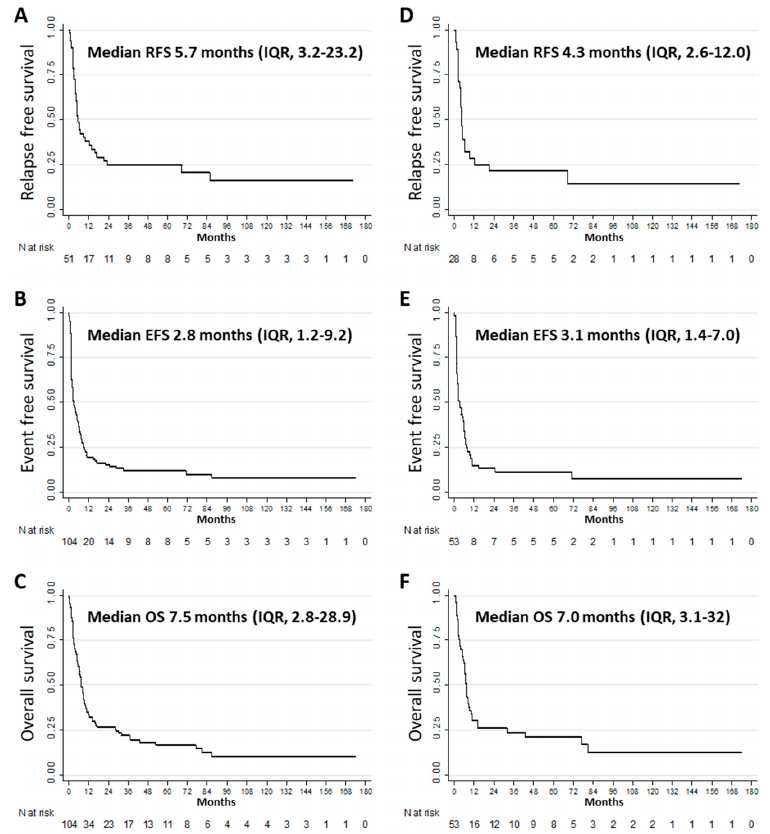
Figure 2. Outcomes among patients with refractory or relapsed FLT3 -ITD acute myeloid leukemia: ( A ) relapse-free survival ( n = 51), ( B ) event-free survival ( n = 104), ( C ) overall survival ( n = 104). Outcomes among patients with refractory or relapsed FLT3 -ITD acute myeloid leukemia < 6 months: ( D ) relapse-free survival ( n = 28), ( E ) event-free survival ( n = 53), ( F ) overall survival ( n = 53).